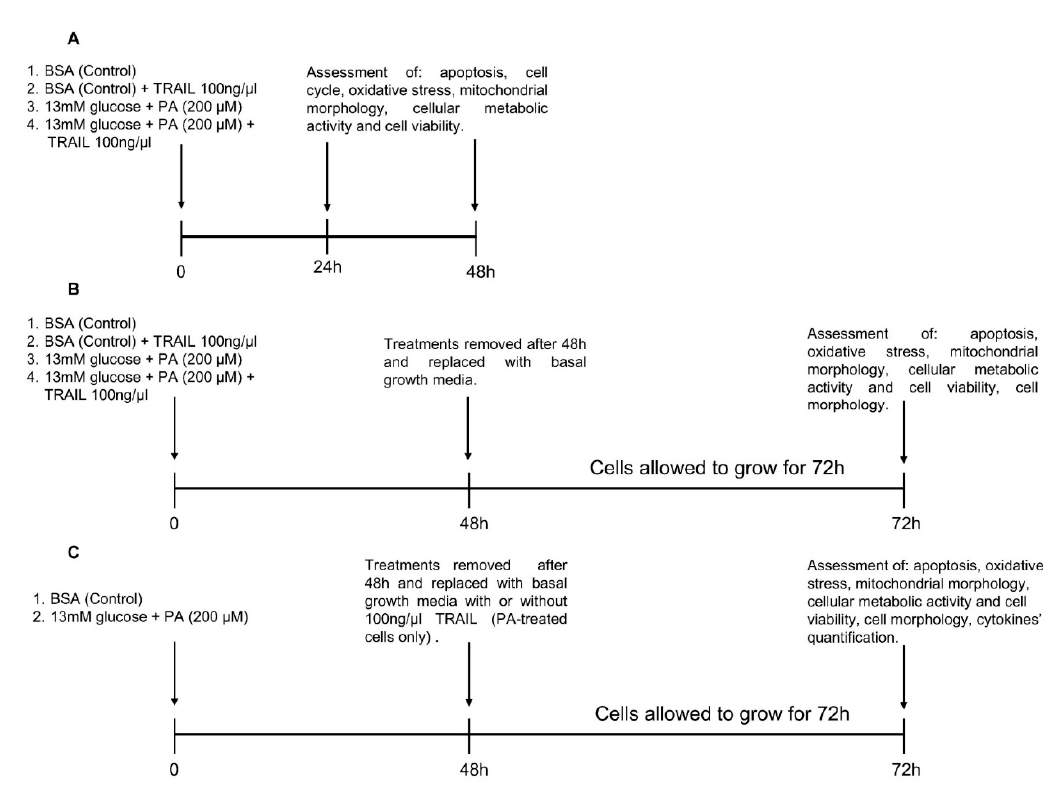
Figure 1. Schematic representation of recovery experiments. ARPE-19 cells were treated with bovine serum albumin (BSA) in the presence or absence of tumor necrosis factor (TNF)-related apoptosis- inducing ligand (TRAIL) as well as palmitic acid (PA) and high glucose concentration (13 mM glucose) with or without TRAIL. In the first sets of experiments ( A ) after 24 or 48 h of treatment the indicated assays were assessed. In the “recovery experiments” ( B , C ), treatments were removed after 48 h and cells were incubated with growth media ( B ) or with growth media in the absence or presence of TRAIL (PA-treated cells only) ( C ) for additional 72 h and then assessed as detailed in the Materials and Methods section.